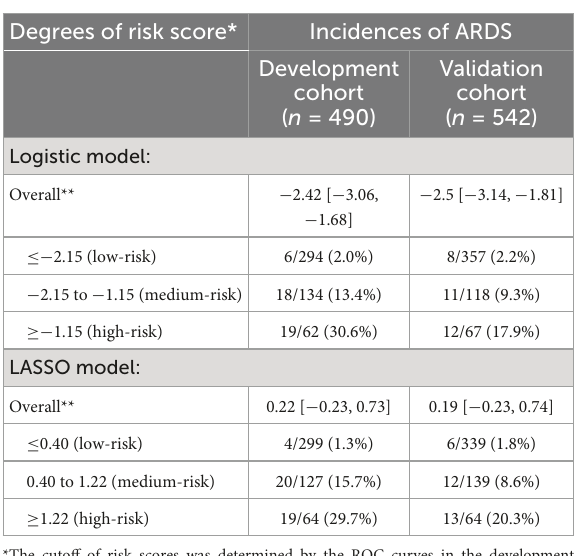
TABLE 4 Subgroup analysis of two prediction models for predicting ARDS in the development